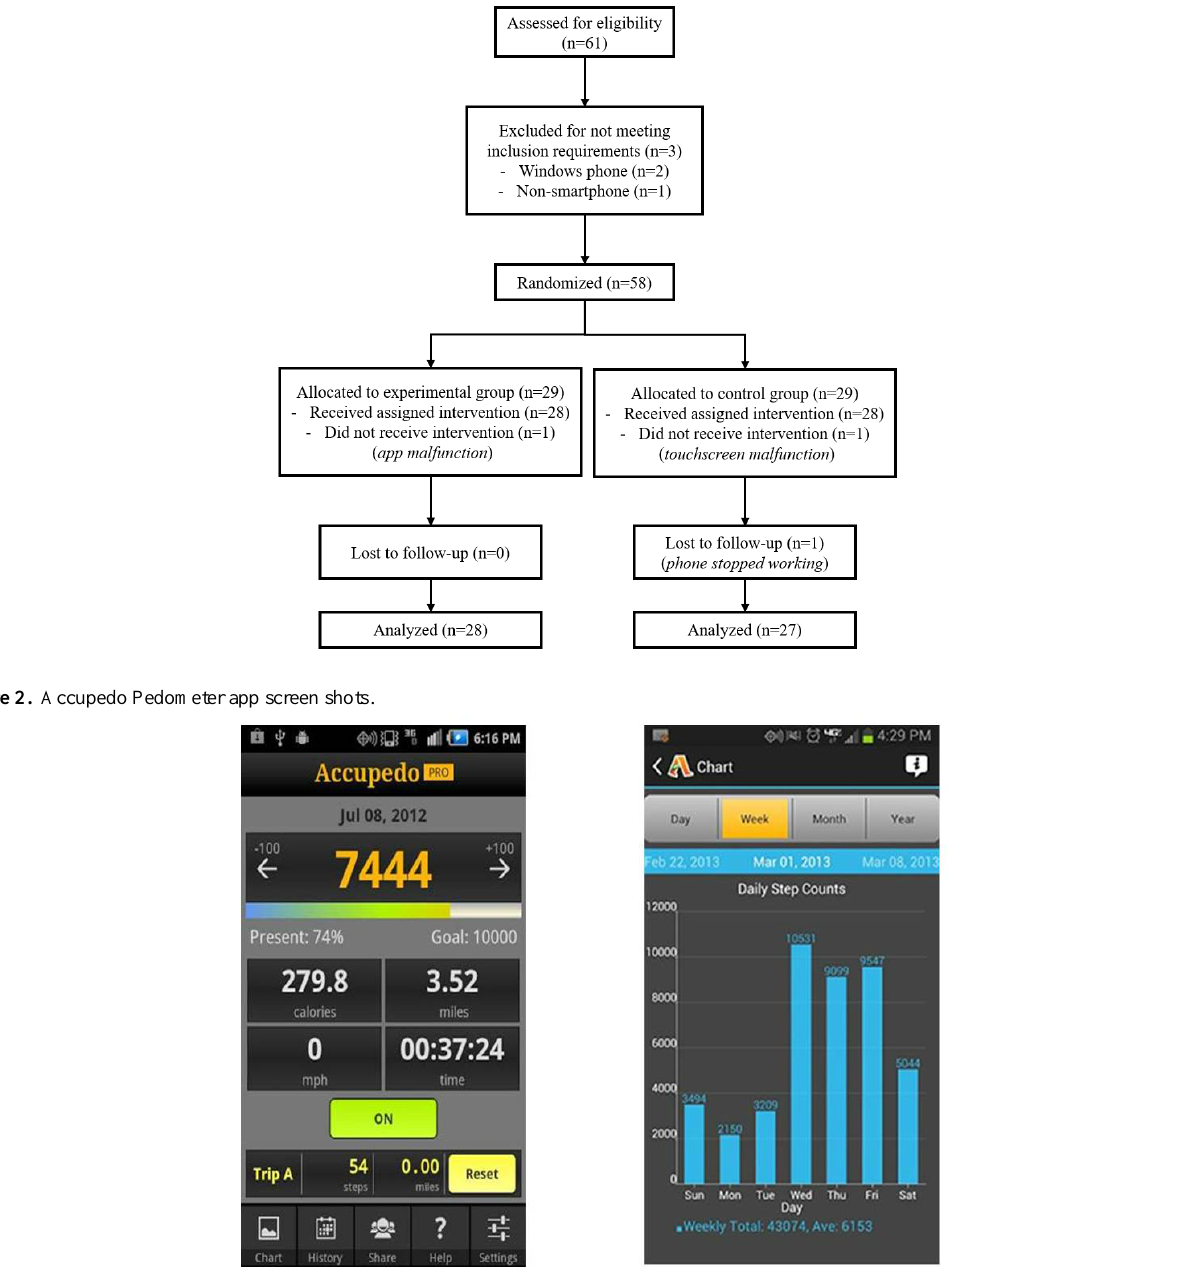
Figure 1. Participant flow from recruitment to follow-up and analysis.